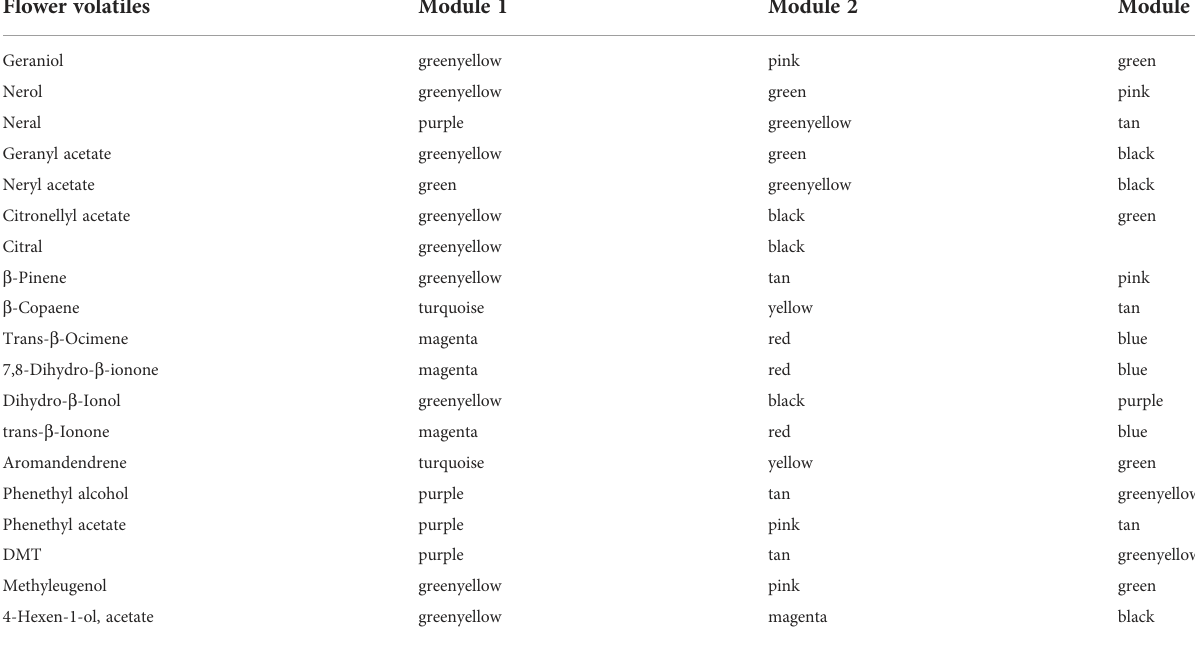
TABLE 2 Modules identi fi ed by weighted gene co-expression network analysis (WGCNA) responsible for fl ower volatiles in rose ‘ Tianmidemeng ’ . Flower